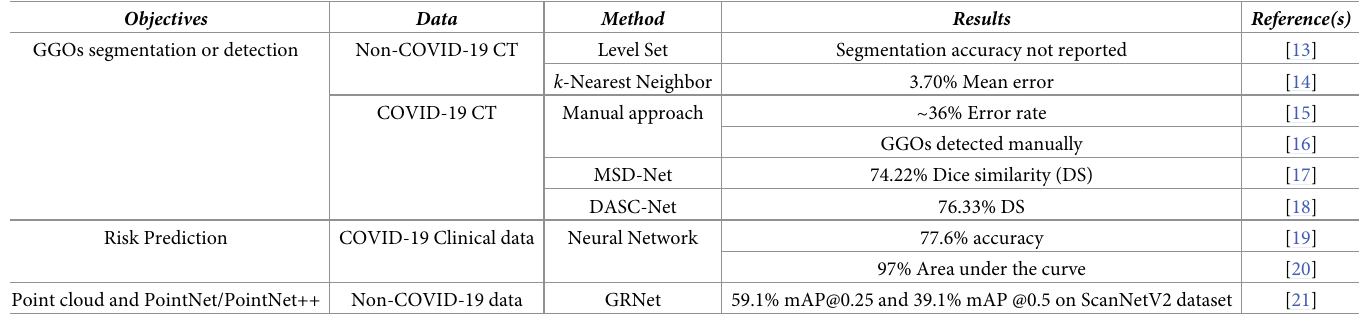
Table 1. Summary of existing